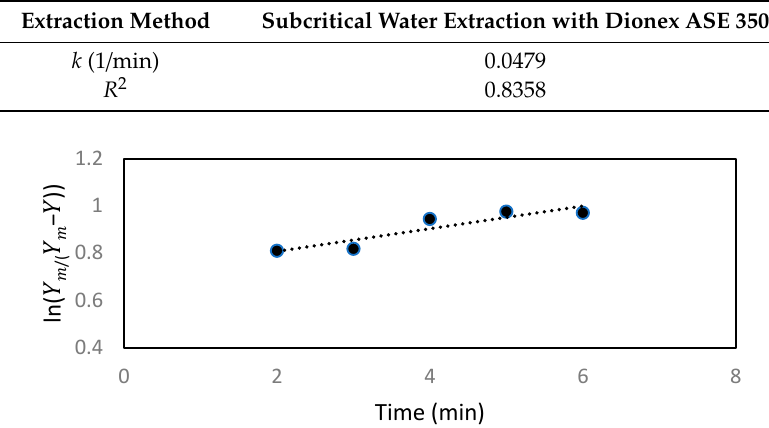
Figure 5. Extraction yield (mg/g) per time.